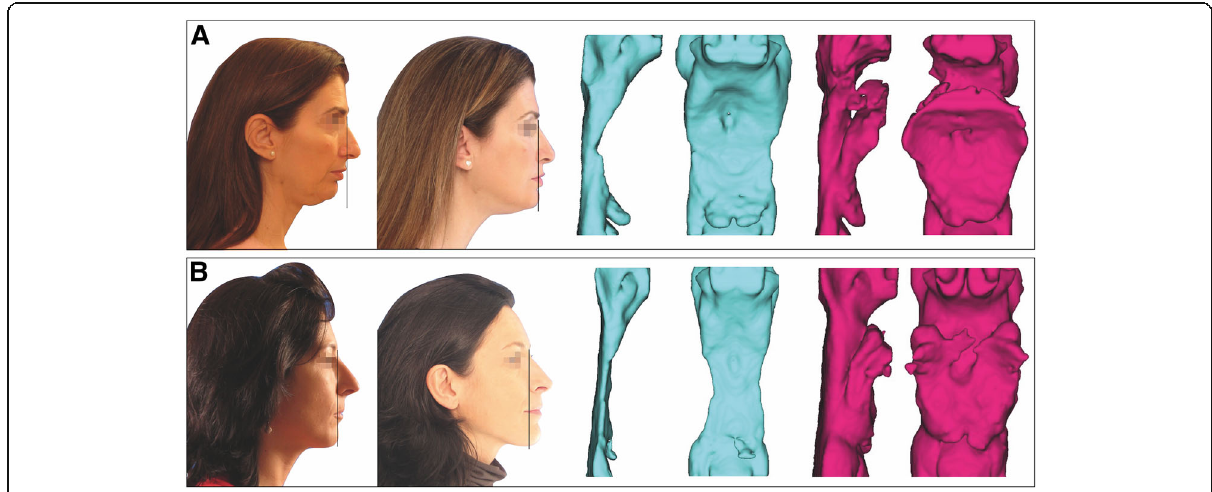
Fig. 7 Pretreatment and posttreatment profile changes in relation to a vertical plane through the soft-tissue nasion and preoperative and postoperative posterior airway space and volume for patient 1 ( a ) and patient 2 ( b